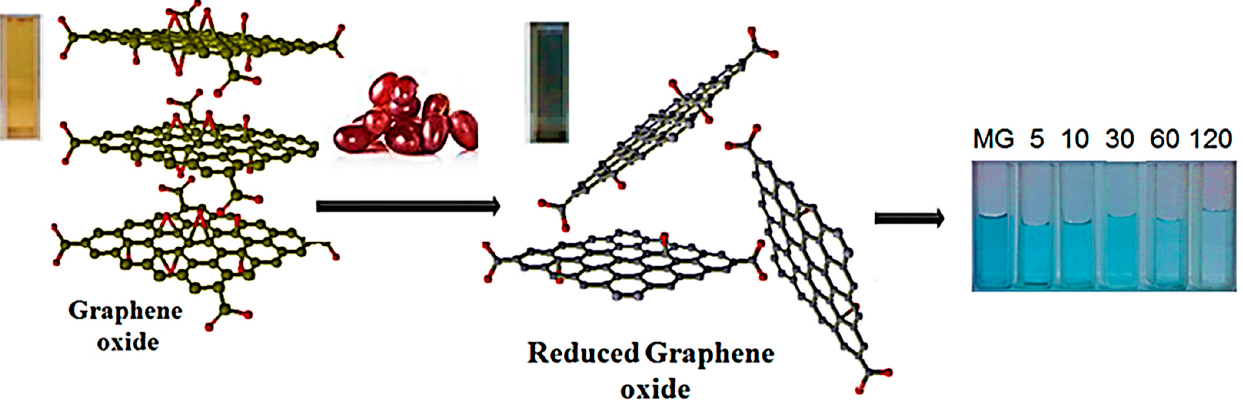
Figure 3. Green synthesis of reduced graphene oxide [81]. Reproduced with permission from Elsevier.